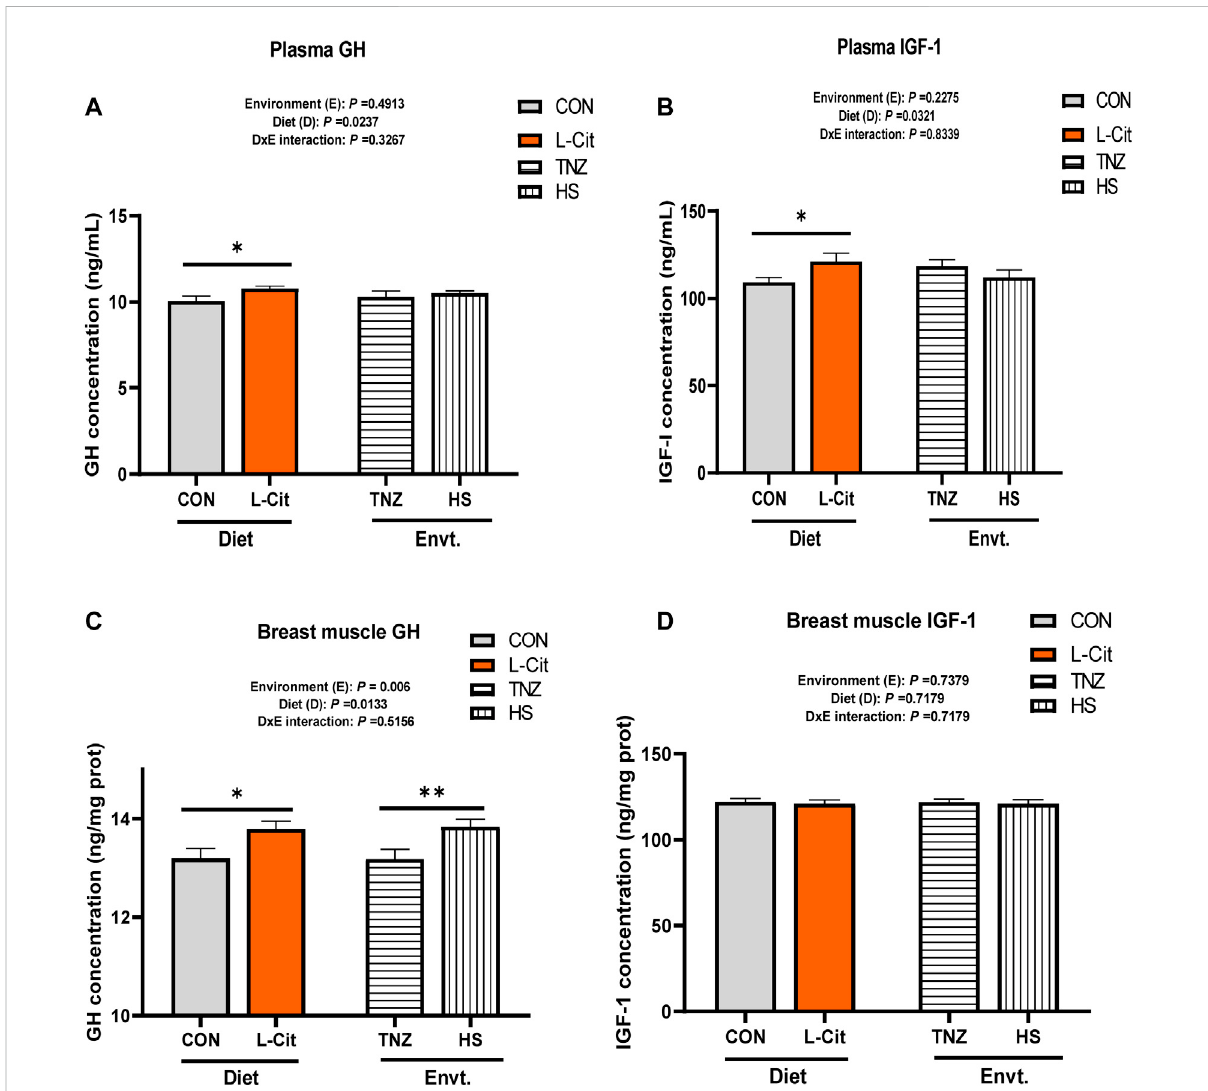
FIGURE 2 Effects of heat stress and l-citrulline supplementation on the concentration of somatotropic axis hormones (A) Plasma Growth hormone (B) Plasma Insulin-like growth factor-1 (C) Growth hormone in breast muscle (D) Insulin-like growth factor-1 in breast muscle. Data were presented as mean ± SEM ( n = 8). Asterisk indicate signi fi cant main effect at * p < 0.05; ** p <